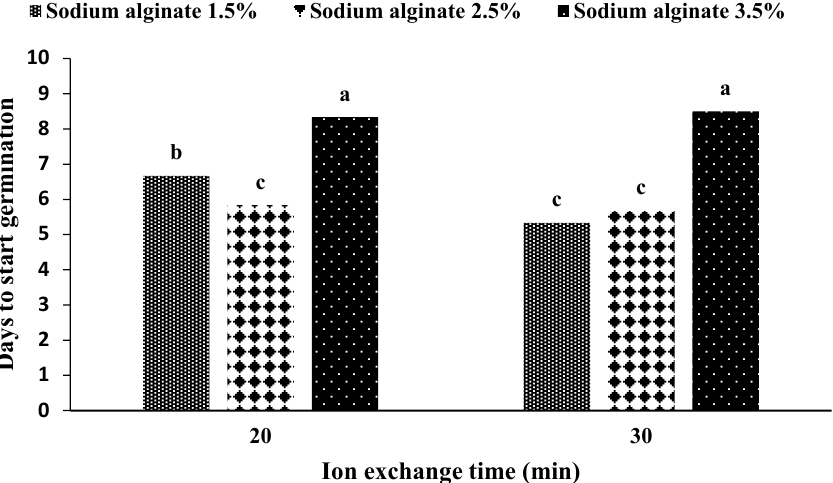
Figure 6. Mean comparison of the number of days until the beginning of germination under the influence of sodium alginate concentration, ion exchange time in artificial seeds of S. pennata . Bars with a common letter do not differ significantly from each other. p < 0.01 probability level (Duncan’s test).